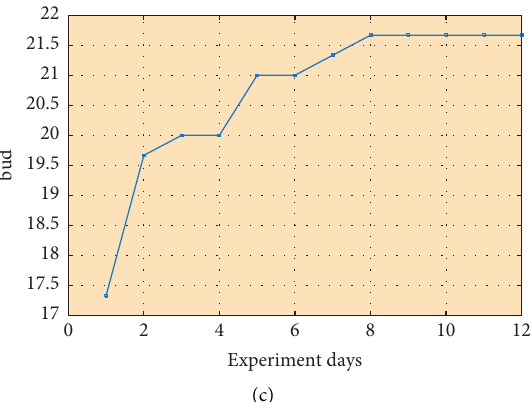
Figure 3: Measurement of cotton plant height, fruit branches, and flower buds. (a) The number of cotton plant height. (b) The number of fruiting branches. (c) The number of flower